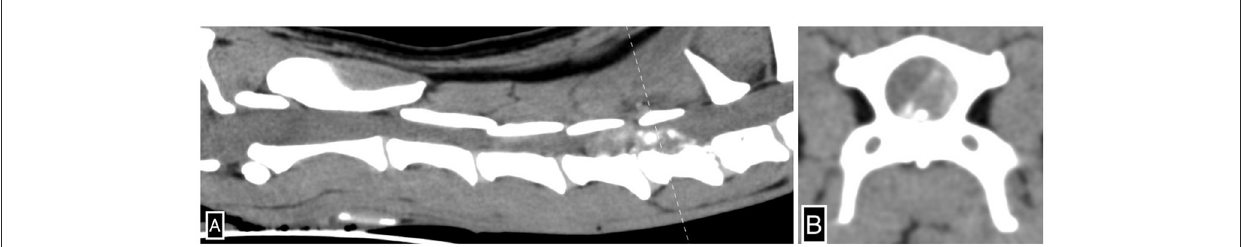
FIGURE1 Severe left-sided C5-6 intervertebral disk extrusion. Sagittal (A) and transverse (B) CT images of the cervical spine illustrate severe mineral-attenuating extradural material in the left ventral aspect of the vertebral canal centered at C5-6 extending cranially to mid-C5 and caudally to C6-7 and subsequent extradural spinal cord compression. The dotted line (A) denotes the axis by which the transverse CT image (B) is reconstructed.